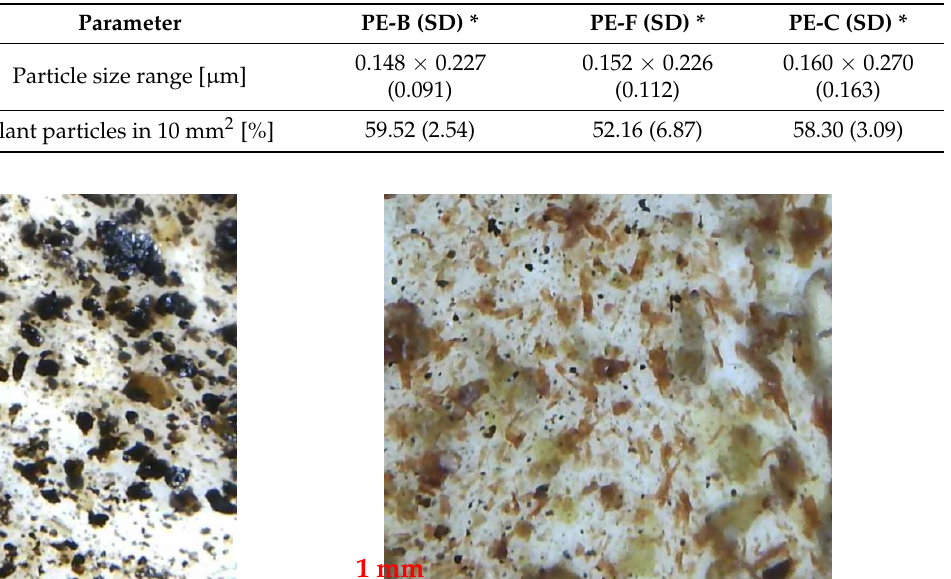
Table 5. Measurement of pomace after oil extraction particles size and their percentage share in PE–pomace based membrane’s surface.